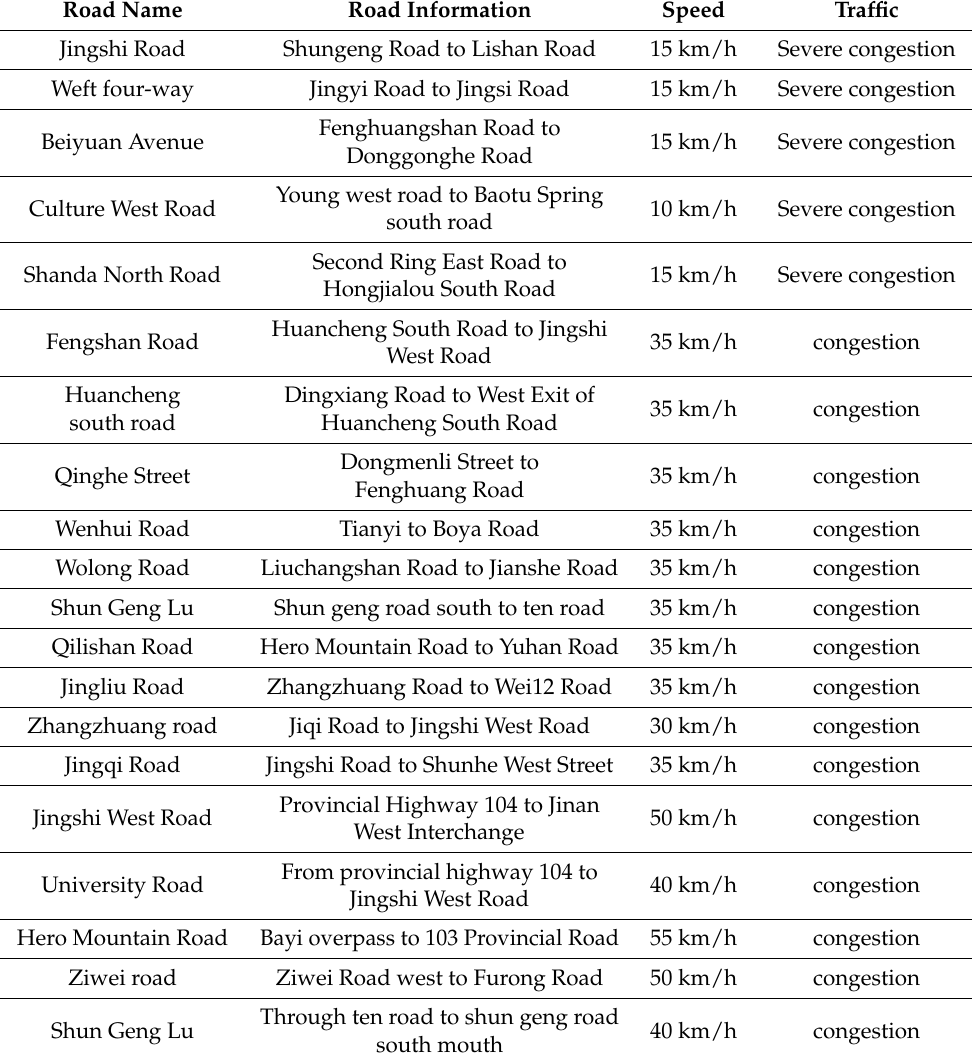
Table 7. Partial data of main roads in evening rush